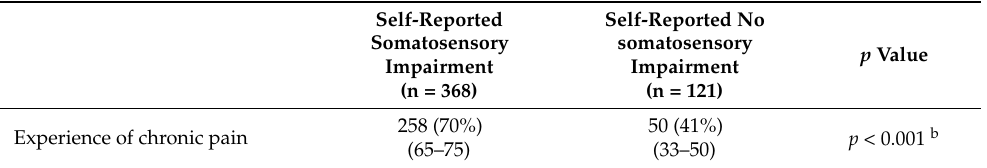
Table 3. Relationship between reported chronic pain and self-reported somatosensory impairment after stroke, with confidence intervals (95%)